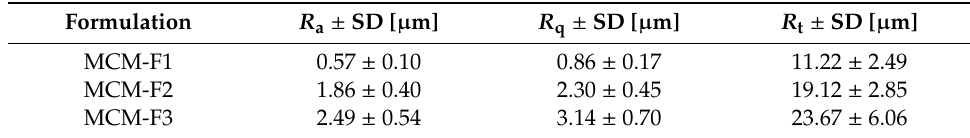
Table 2. Mean roughness parameters with standard deviations of surface of MCM-F1, MCM-F2, MCM-F3 solid films.